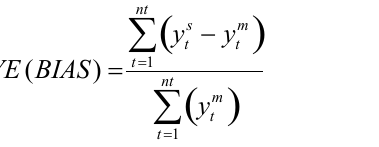
and Θ for S ini